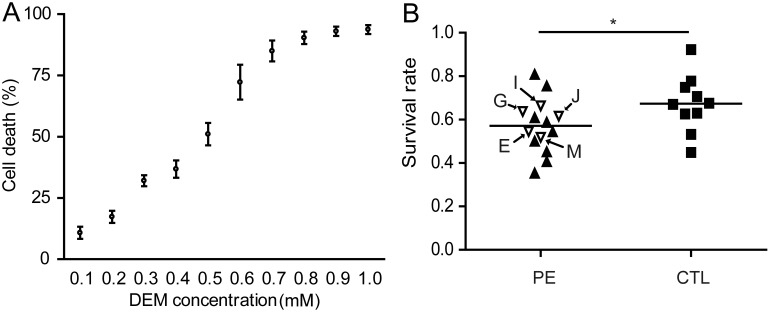
Effect of diethylmaleimide (DEM) on growth of UC fibroblasts.(A) Dose response to increasing concentrations of DEM. Fibroblasts (4 PE, L, M, N, O; 4 CTL, #6, 7, 8, 9) were sub-cultured into 96-well plates at p 3 at a density of 3,200 cells/well in LG/4% O2 conditions for 24 h. They were then exposed to DEM (final concentrations 0.1 mM to 1.0 mM) for a further 24 h under the same culture conditions. The washed cells were fixed and stained with 0.1% crystal violet, the dye extracted in 10% ethanol/0.1 M sodium citrate, and absorbance (OD) measured at 595 nm. Values are presented as (ODcontrol−ODDEM)/ODcontrol. (B) Relative abilities of PE and CTL fibroblasts to survive 0.4 mM DEM for 24 h. The experimental design was that in Fig. 4A, but utilized a single concentration of DEM and 14 PE and 10 CTL lines. The open triangles indicate the five PE (O2-s; E, G, I, J, M) lines that failed to form outgrowths in 20% O2 (*P≤0.05).